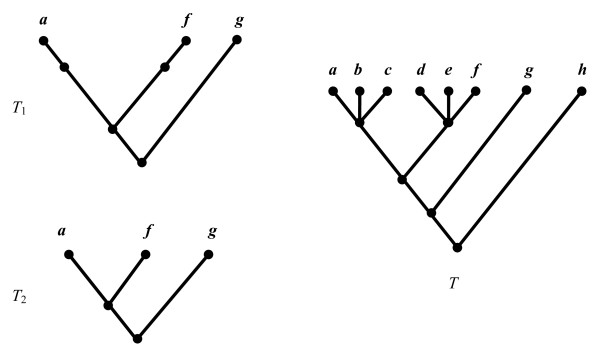
T(A) and T|A. For A = {a, f, g}, T1 is the tree T(A) and T2 is the tree T|A.